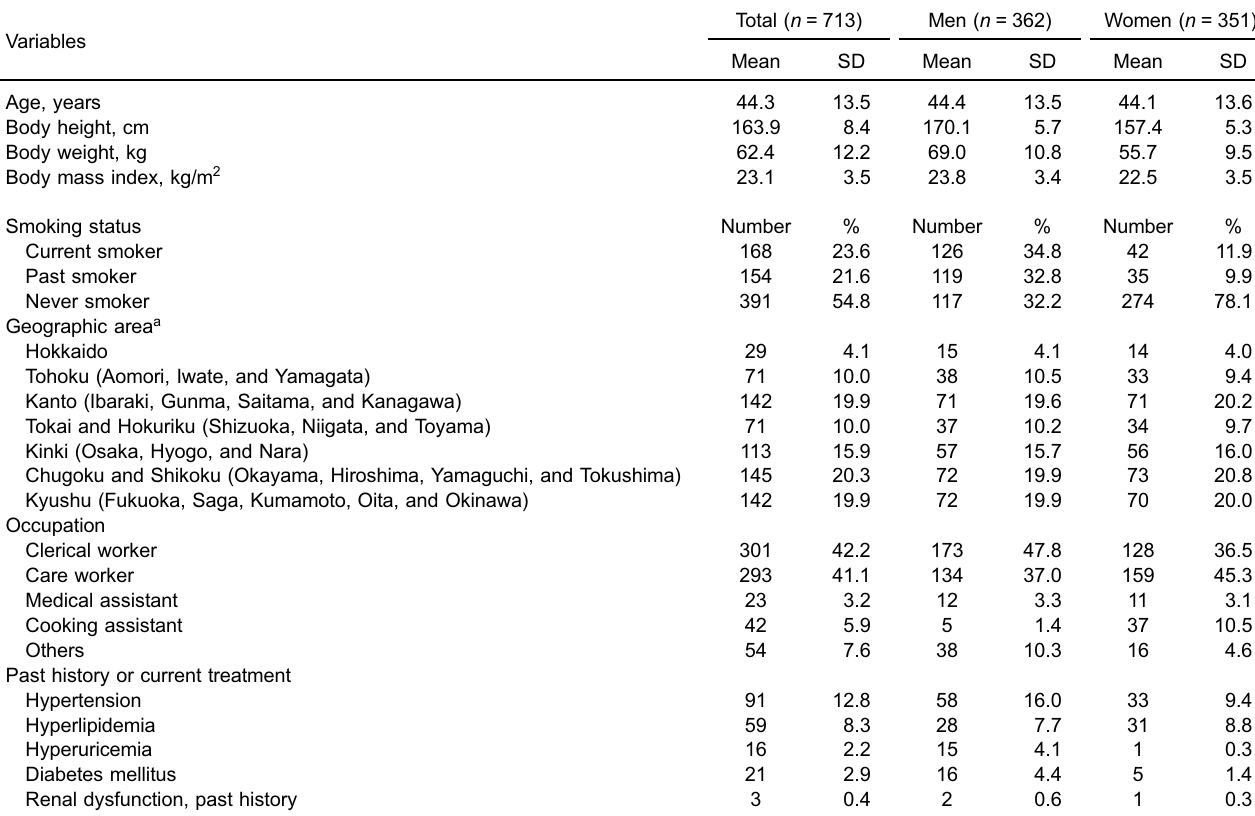
Table 1. Basic characteristics of study participants Variables